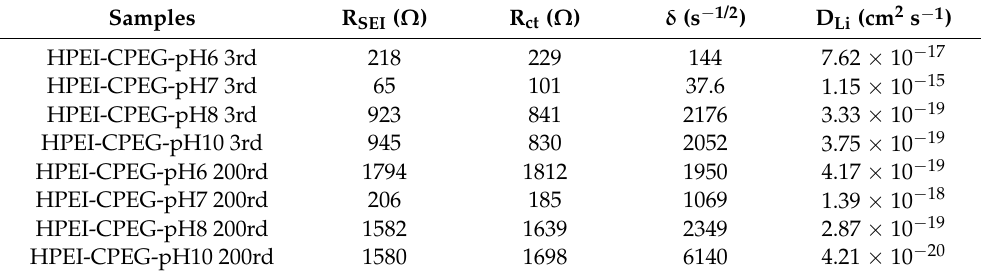
Table 1. Impedance parameters of HPEI-CPEG-pH6, HPEI-CPEG-pH7, HPEI-CPEG-pH8, and HPEI- CPEG-pH10